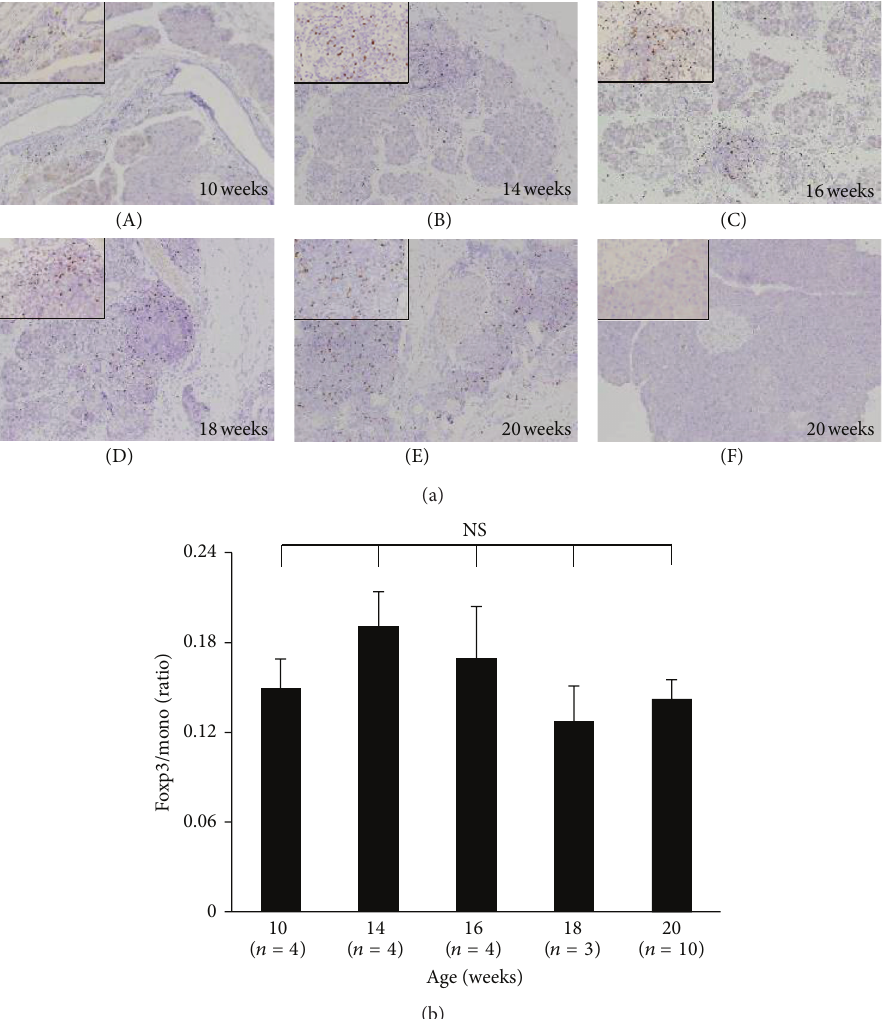
Figure 3: Representative immunostaining of Foxp3 in the pancreases (a) and the ratios of Foxp3/mono (Foxp3-positive cells/infiltrated mononuclear cells) in the pancreases (b) in poly I:C-treated MRL/Mp mice in the 5 different age groups. The abundant infiltration of Foxp3- positive cells was found among the lymphoid infiltrates in the pancreases. There were no differences in Foxp3/mono ratios among poly I:C-treated MRL/Mp mice at the ages of 10, 14, 16, 18, and 20 weeks. Poly I:C-treated MRL/Mp mice (A)–(E), controls (F). × 100 magnification (large panel), × 400(inset). Data are expressed as mean ± SEM; NS, not